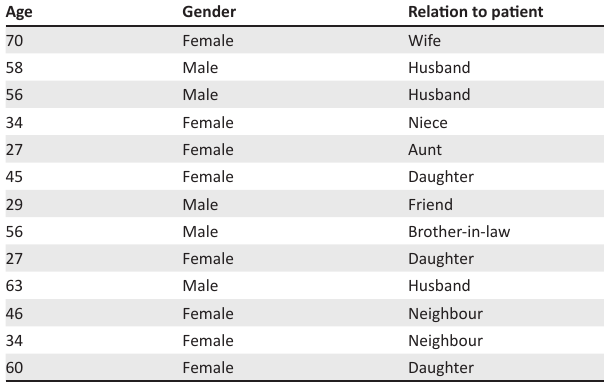
TABLE 1a: Caregiver demographics.